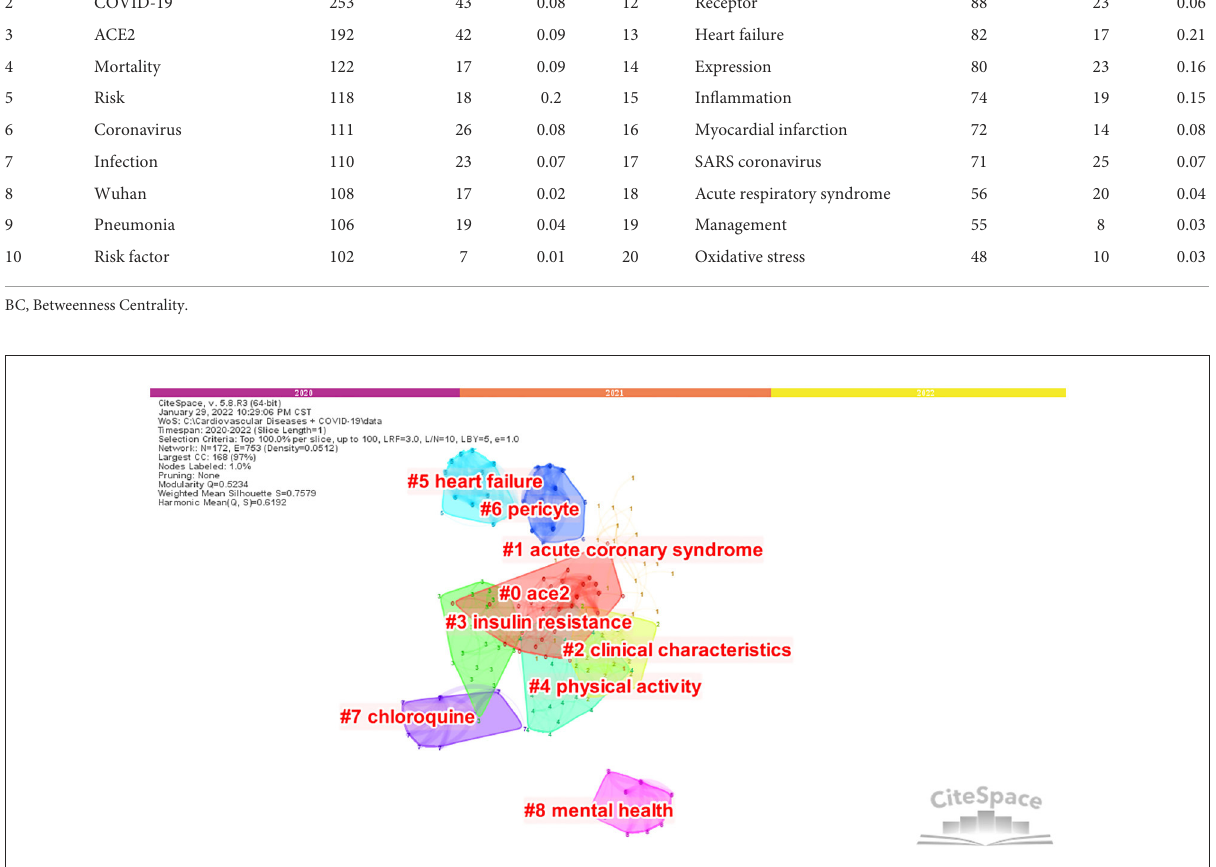
6.02, followed by “pathogenesis” and “respiratory syndrome” at 4.18 and 3.65, respectively. The next 17 top keywords with the strongest citation bursts were: angiotensin converting enzyme 2, inhibition, chloroquine, myocarditis, model, blockade, SARS- CoV, MERS-CoV, c reactive protein, severity, death, coronary artery disease, NF- κ B, endothelial cell, cancer, admission, and body mass